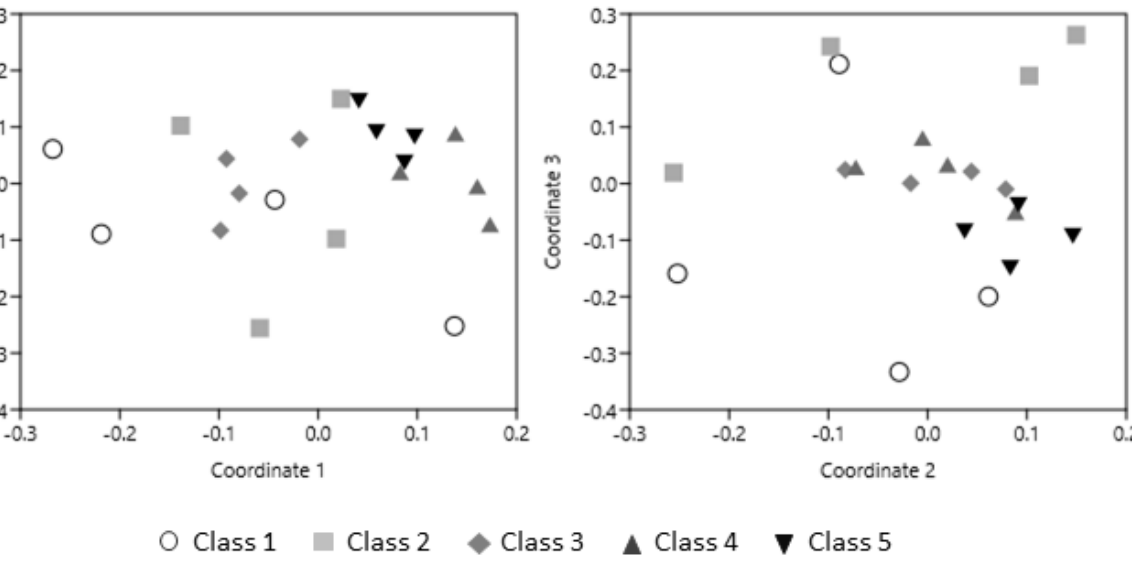
Figure 1. Three-dimensional nMDS ordination plots of PCR-DGGE profiles obtained by amplification of ciliate 18S rDNA from black pine deadwood samples of the different decay classes collected in the Pratomagno study area (stress = 0.18). The distance between the same symbols is inversely proportionated to the degree of similarity between the ciliate community within a decay class. Three-dimensional (3D) nMDS was preferred since it led to lower distortion than two-dimensional nMDS.